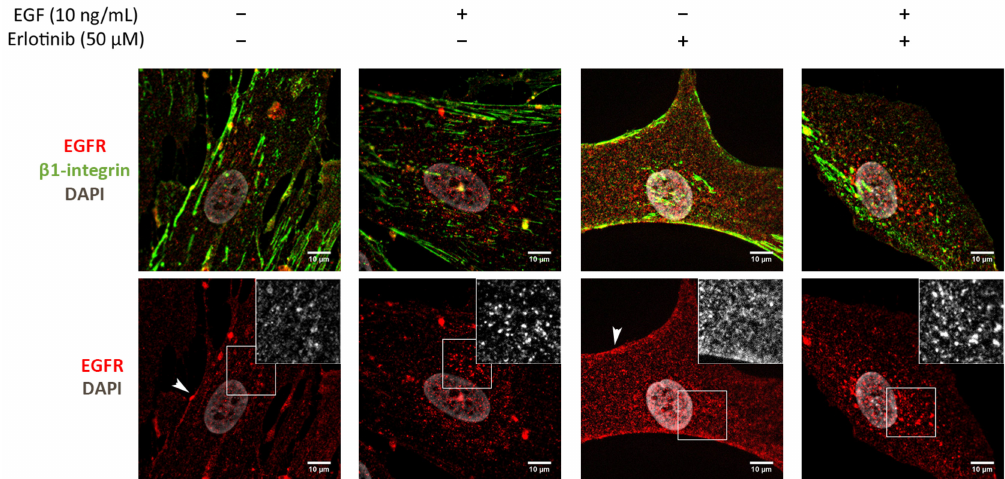
Figure 5. Immunofluorescence analysis of the EGFR in hNDF cells incubated with EGF, erlotinib or both in 2D cultures. Scale bars represent 10 µ m. Insets represent high magnification images of the region indicated by a white